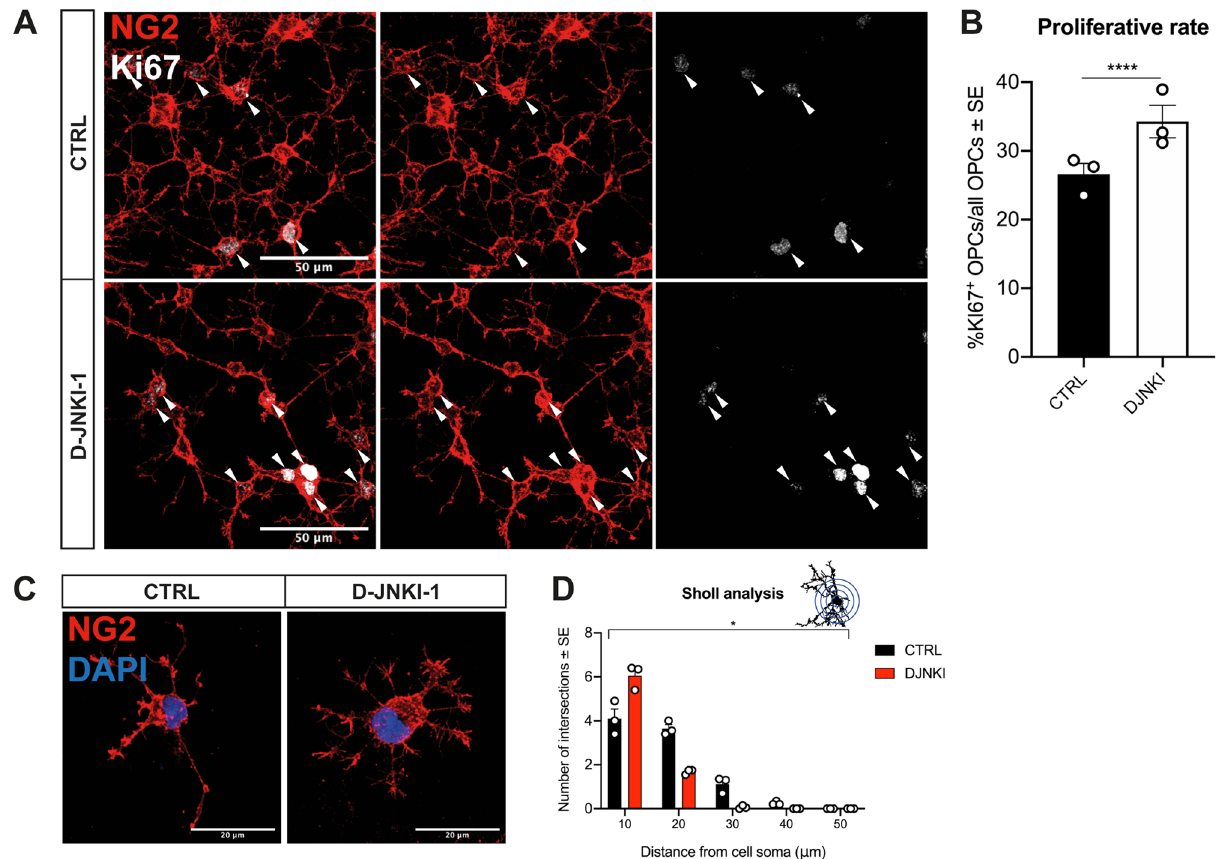
Figure 5. D-JNKI-1 treatment of rat OPCs mimics JNK1 KO in vitro. ( A ) Representative images and ( B ) quantification of proliferative rat NG2 + CTRL vs D-JNKI-1-treated OPCs (red). Ki67 + proliferating cells (white) are indicated by white arrows. ( C ) Representative images and ( D ) Sholl analysis of CTRL vs D-JNKI-1-treated OPCs (red). DAPI (blue) counterstains cell nuclei. Asterisks in ( D ) Two-way ANOVA (main effect of genotype). Scale bars: 50 μm in ( A ) and 20 μm in ( C ). CTRL control cells, D-JNKI-1 JNK1 inhibitor-treated cells, NG2 neural/glial antigen 2, Ki67 Ki67 antigen. *P < 0.05; **P < 0.01; ****P <